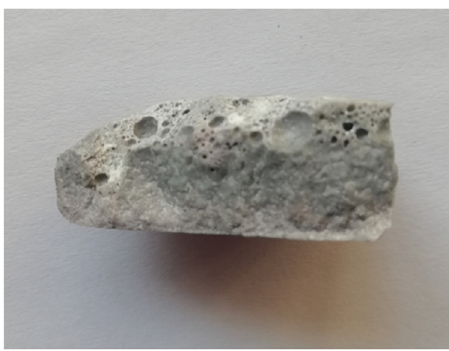
Figure 1: Macro morphology of slag after reaction.